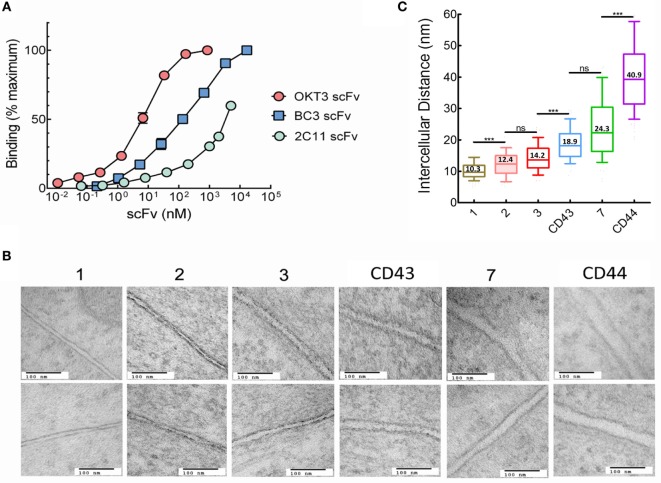
Intercellular distances between T cells and 3T3 antigen-presenting cells (APCs) depends on tether dimensions. (A) Binding of serial dilutions of OKT3 scFv, BC3 scFv, or 2C11 scFv to Jurkat (OKT3 and BC3) or 2B4 (2C11) T cells was determined by ELISA. Results show scFv binding relative to maximum binding of the individual scFv. Maximum binding was estimated for 2C11 scFv because saturation was not reached even at the highest concentration (250 µg/ml) of 2C11-BGP scFv examined. (B) Images of the interphase between Jurkat and 3T3 cells expressing the indicated membrane-anchored OKT3 scFv (150,000× original magnification. Scale bars, 100 nm). (C) Estimated mean intercellular distance between Jurkat and 3T3 cells expressing OKT3 scFv. Intercellular distances were measured at 11–20 equally spaced distances from 9 to 15 independent T cell-APC conjugates for each tether (n = 15, 15, 10, 9, 10, and 10 for 3T3 cells expressing OKT3-1, OKT3-2, OKT3-3, OKT-CD43, OKT3-7, and OKT3-CD44, respectively). The box and whisker plot shows the mean intercellular distances, the 10–90 percentile (box) and the minimum and maximum values (whiskers). Significant differences of intercellular distances between 3T3 cells expressing OKT3 scFv with different tethers are indicated (***p < 0.0001).